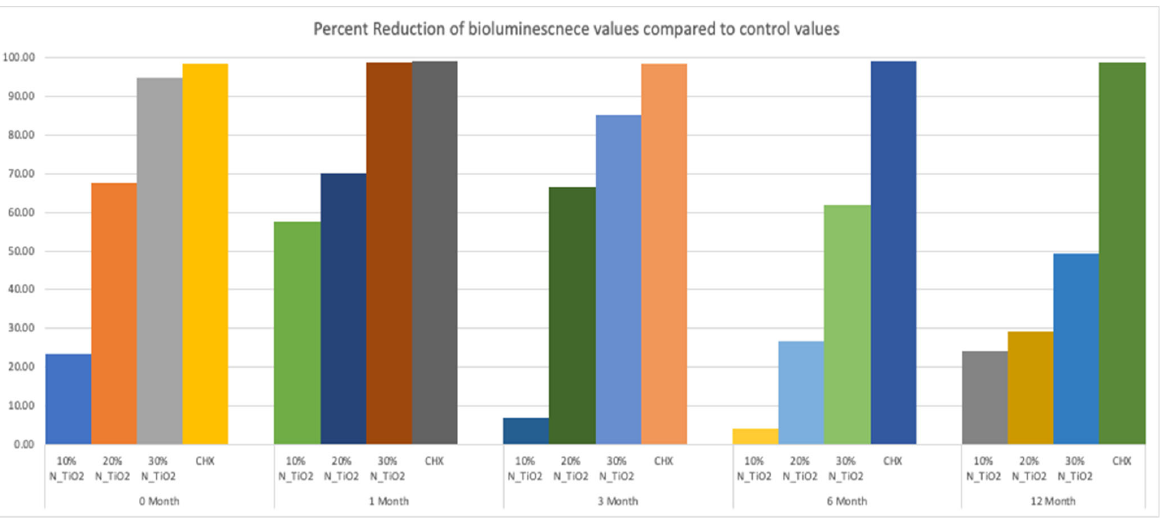
Figure 8. Percent reduction of bioluminescence values of experimental adhesive resins that were fabricated and aged in PBS, when compared to unaltered OPTB. Biofilms grown on fabricated spec ‐ imens that exhibited higher concentrations of nanoparticles showed greater decrease in biolumines ‐ cence, however the percent reduction decreases over time. CHX is to serve as a well ‐ established positive control.